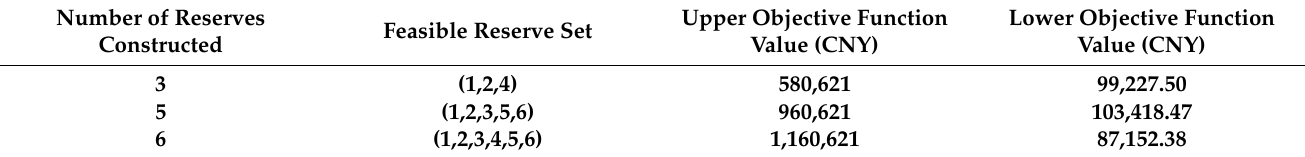
Table 6. Ant colony algorithm to obtain feasible set and its